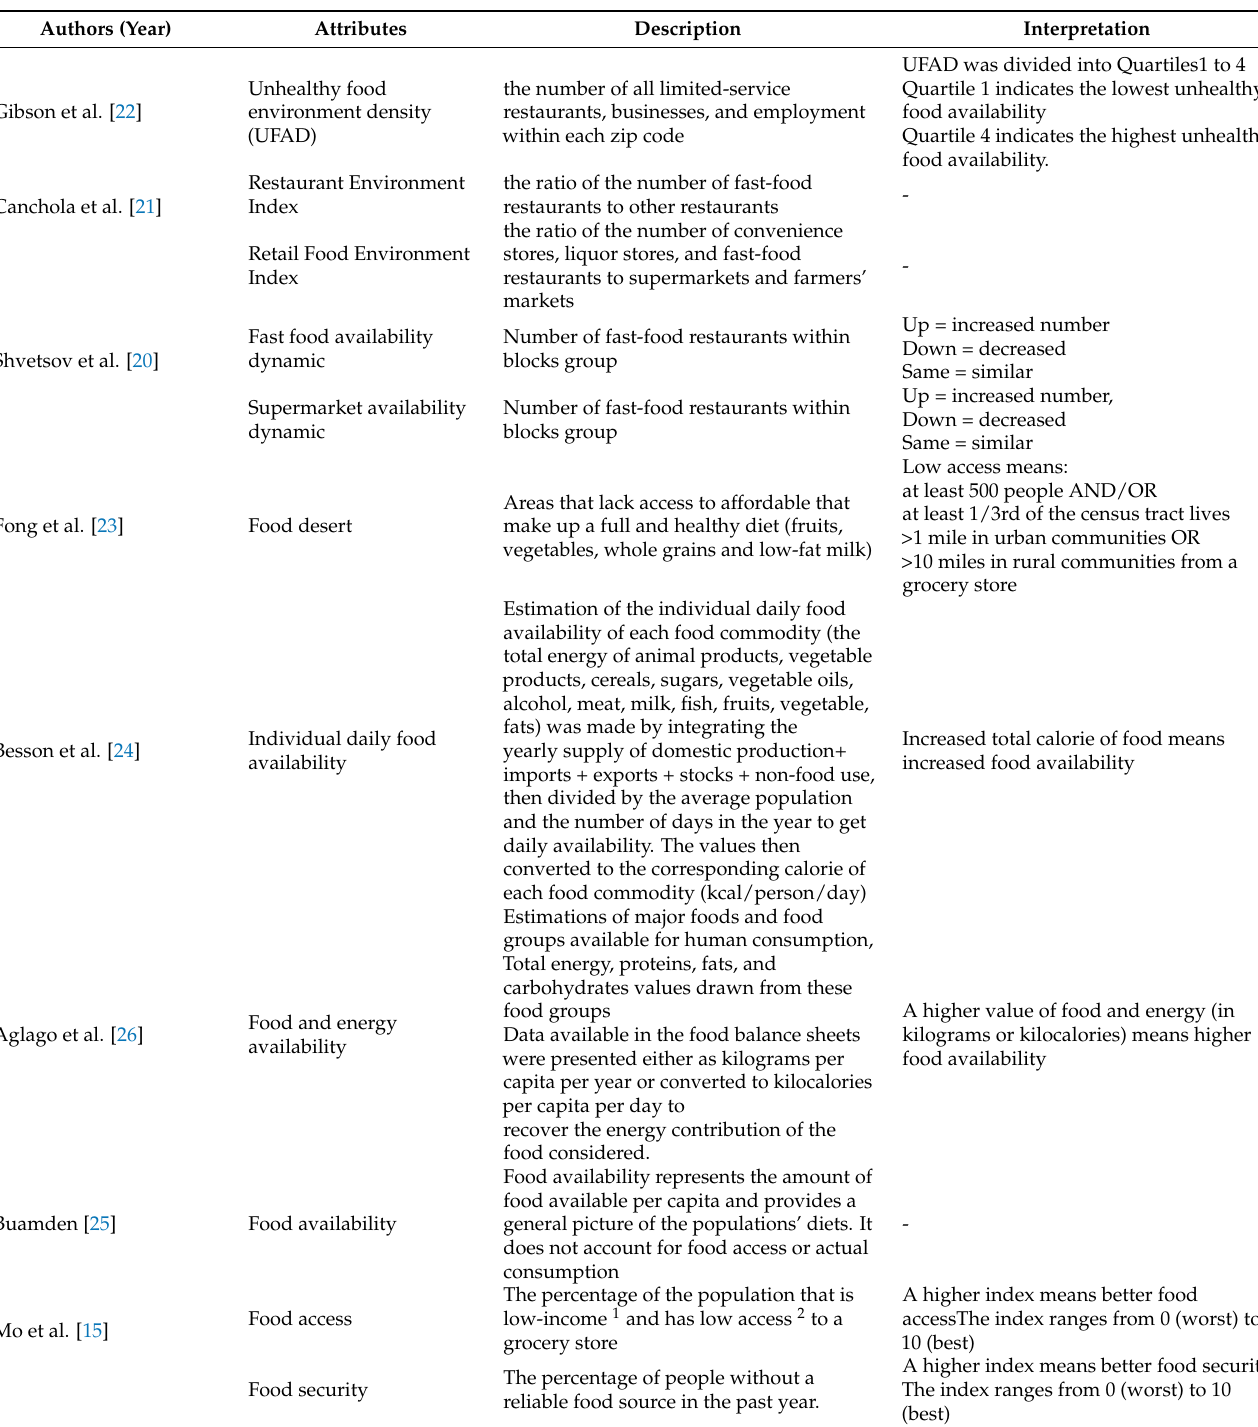
Table 5. Food environment attributes in the included study, how it was measured, description and